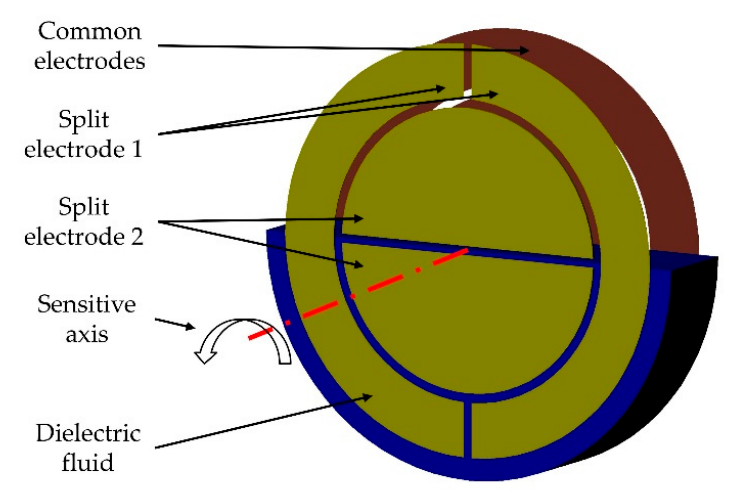
Figure 13. Functional principle with four electrodes in one cavity. The differential capacitive measurement principle is shown in Figure 14. A capacitance to digital converter (CDC) Analog Devices AD7746 is used to measure the capacity. Some technical data of the CDC are given in Table 2. The measurement values are transferred from the CDC via I2C to a